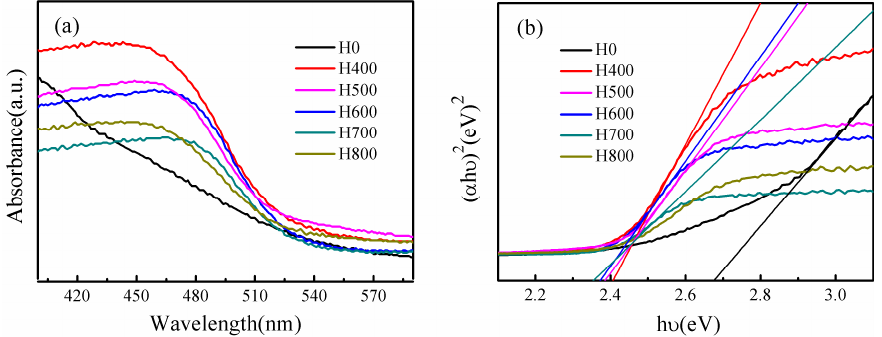
Figure 5. ( a ) UV-vis diffuse reflectance spectra, ( b ) Plots of( α h υ ) 2 versus photon energy (h υ ) of BiVO 4 synthesized under different conditions.